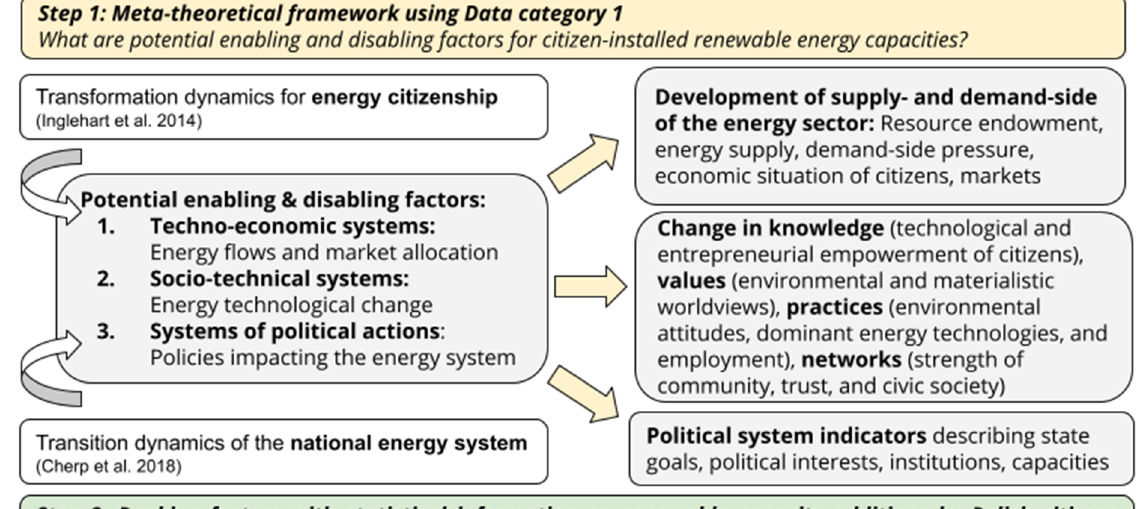
Figure 1. Two-step research method, confronting two types of empirical data. Data category 1 describes the Polish energy system (see Table 1). Category 2 has empirical data on citizen-installed renewable energy capacities (Table 2) [20,21].